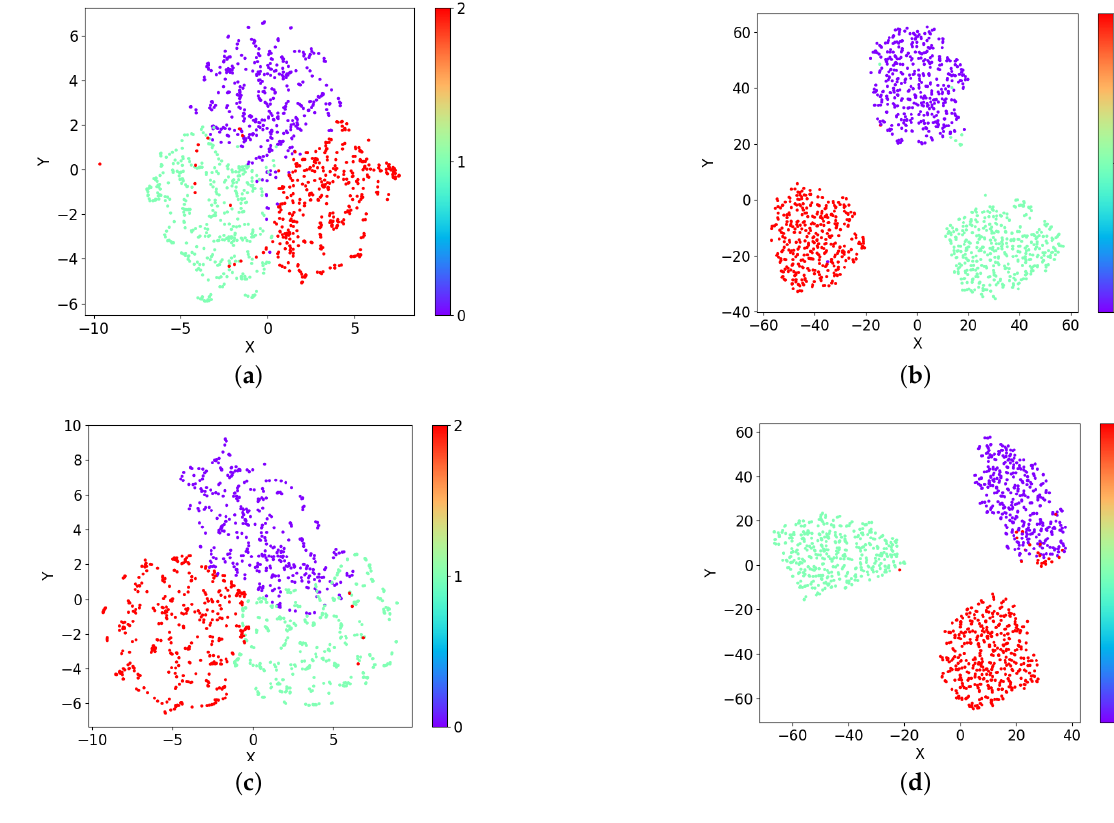
Figure 14. Representations of complex clutter scenes in different spaces. Case A: ( a ) original space representations, ( b ) z -space representations of GM-CVAE; case B: ( c ) original space representations, ( d ) z -space representations of GM-CVAE. Herein, case A represents data pre-processing with MTI or AMTI and case B indicates data pre-processing without MTI or AMTI.